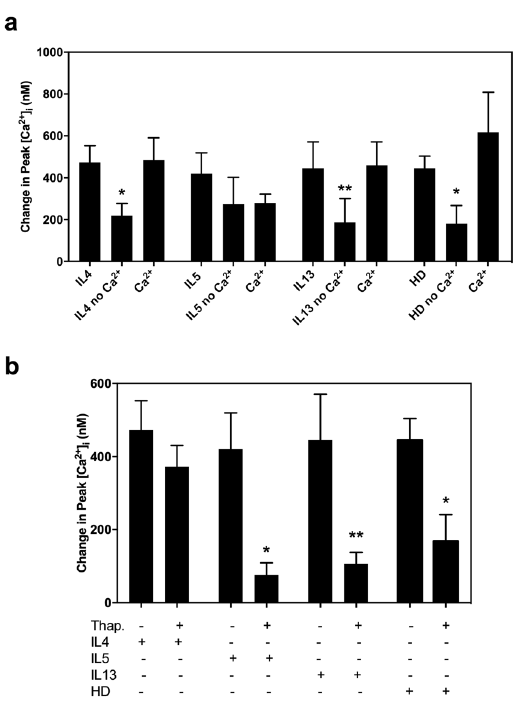
Figure 6. Effect of extracellular and intracellular Ca 2 + stores on IL cytokine induced increase in intracellular [Ca 2 + ] ([Ca 2 + ] i ) in rat conjunctival goblet cells. ( a ) Peak [Ca 2 + ] i over basal after stimulation with IL4, IL5, IL13 each at 10 ng/ml and histamine dimaleate (HD) at 10 − 5 M in the presence of extracellular Ca 2 + or in the absence of extracellular Ca 2 + (no Ca 2 + ), and followed by the readdition of extracellular Ca 2 + . ( b ) Peak [Ca 2 + ] i over basal for IL4, IL5, IL13 and histamine dimaleate (HD) alone or after a 15 min treatment with 10 − 5 M thapsigargin (Thap.). Data are mean ± SEM from five independent experiments. * p ≤ 0.05; ** p ≤